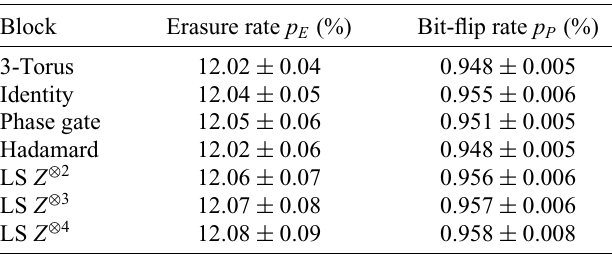
TABLE I. Threshold values for various logical blocks. Here LS stands for lattice